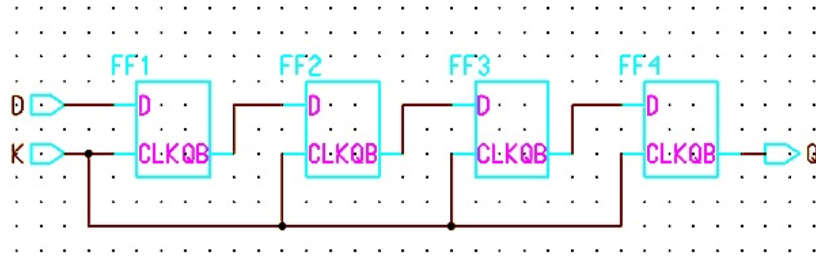
Figure 8. Schematic of the four-bit serial in –serial out (SISO) shift register.